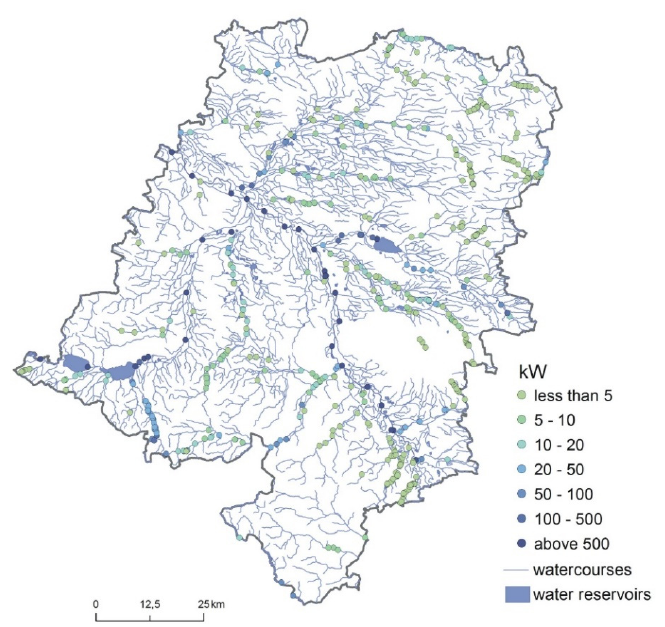
Figure 13. Localization of water dams and power of the potential hydropower plants in the Opolskie voivodeship (own elaboration).